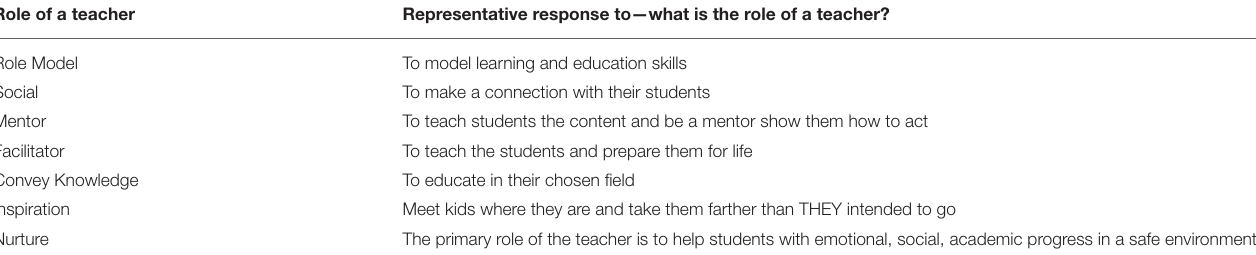
TABLE 8 | Representative responses of the roles of teachers coded for the role of a teacher. Role of a